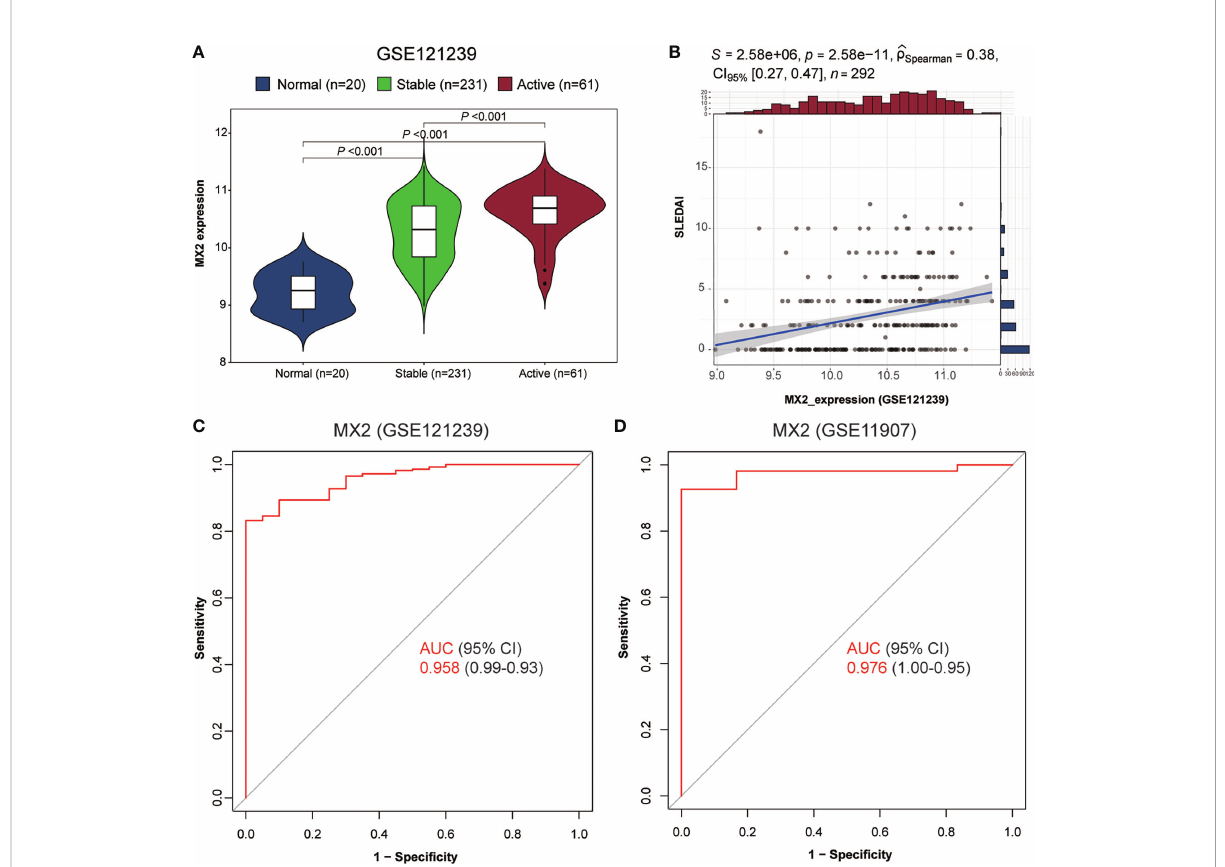
FIGURE 4 MX2 was highly expressed in SLE and served as a biomarker for diagnosis and disease activity. (A) Comparison of MX2 expression in normal and different stages of SLE. (B) Correlation of MX2 with SLEDAI. (C) The ROC curve for diagnostic ef fi cacy validation of MX2 in GSE121239. (D) The ROC curve for diagnostic ef fi cacy validation of MX2 in